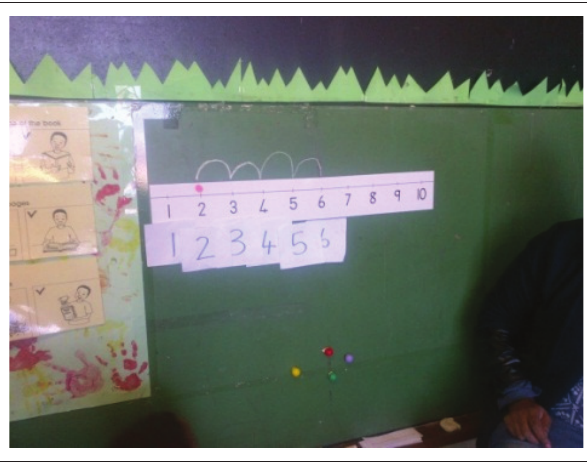
FIGURE 2: A learner shows how to hop from 2 to 4 on the number line.